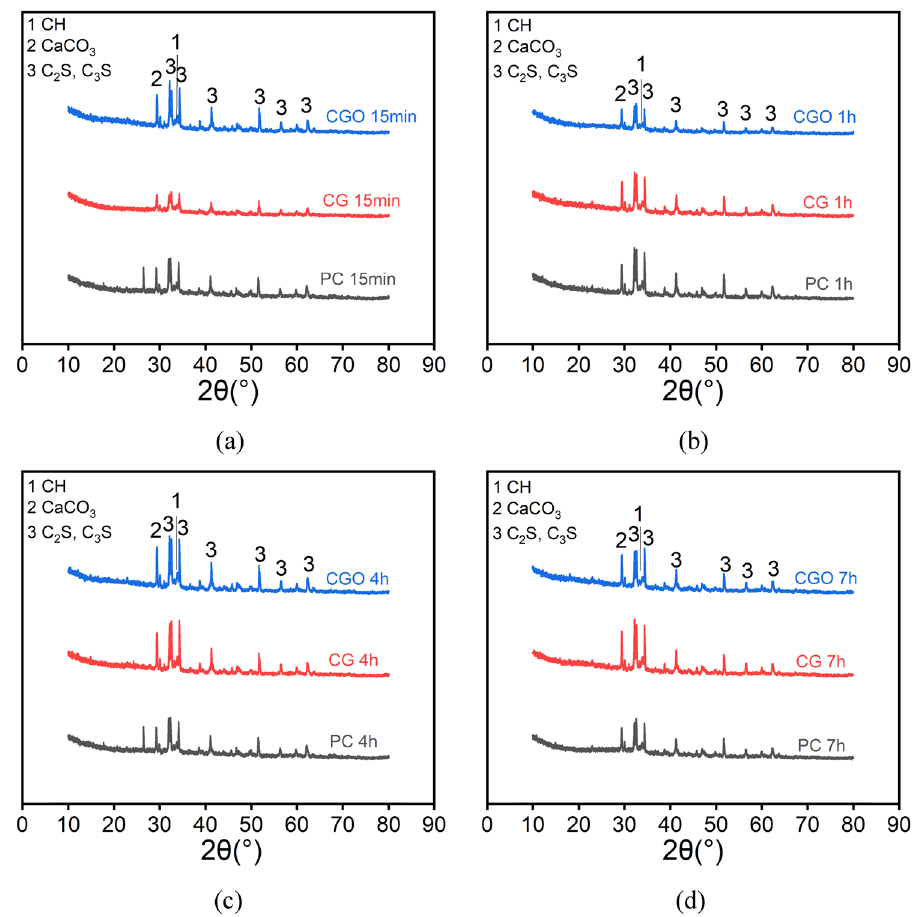
Figure 5: XRD patterns of the sample at 15 min ( a ) , 1 h ( b ) , 4 h ( c ) , and 7 h ( d )